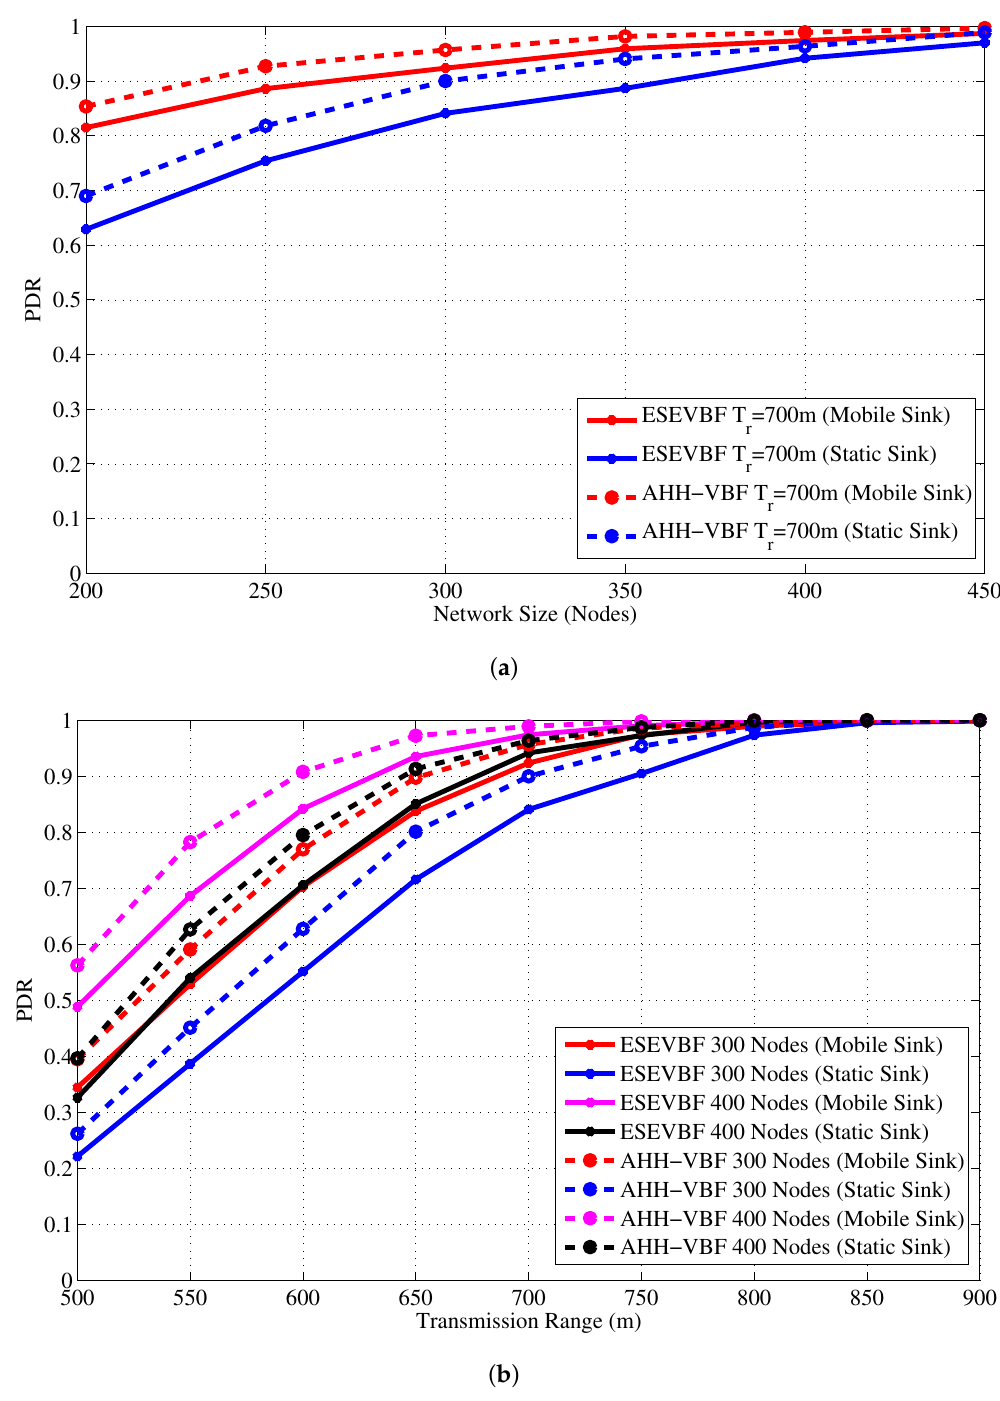
Figure 23. PDR in the static and mobile Sink network scenario for varying ( a ) network size ( b ) transmission